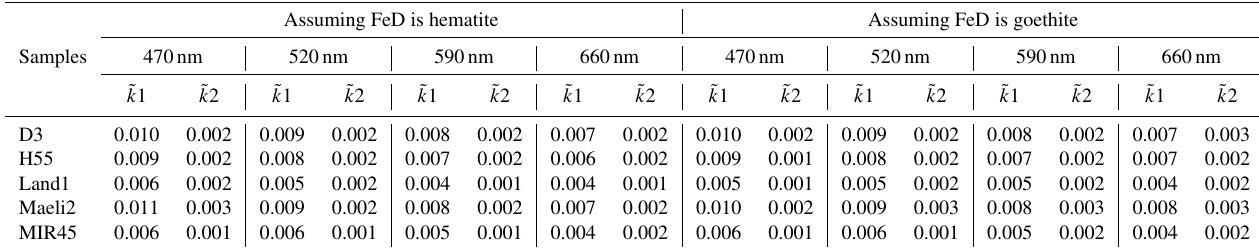
Table 3. Estimated imaginary part of the volume-average refractive index of Icelandic dust (PM 10 fraction). Assuming FeD is hematite Assuming FeD is goethite